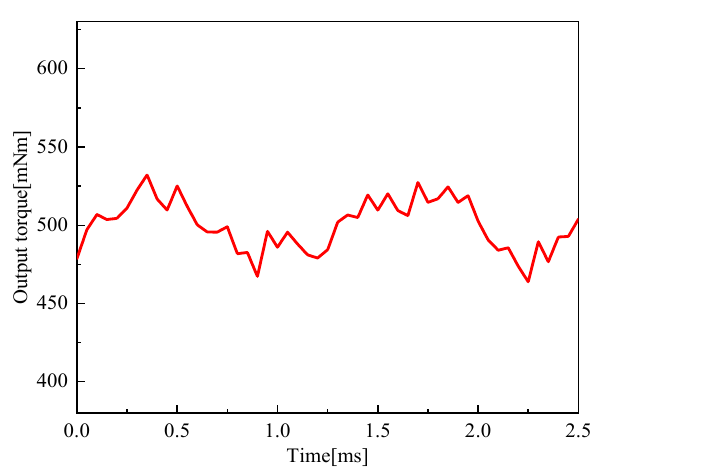
Figure 10. Loaded stator winding flux.